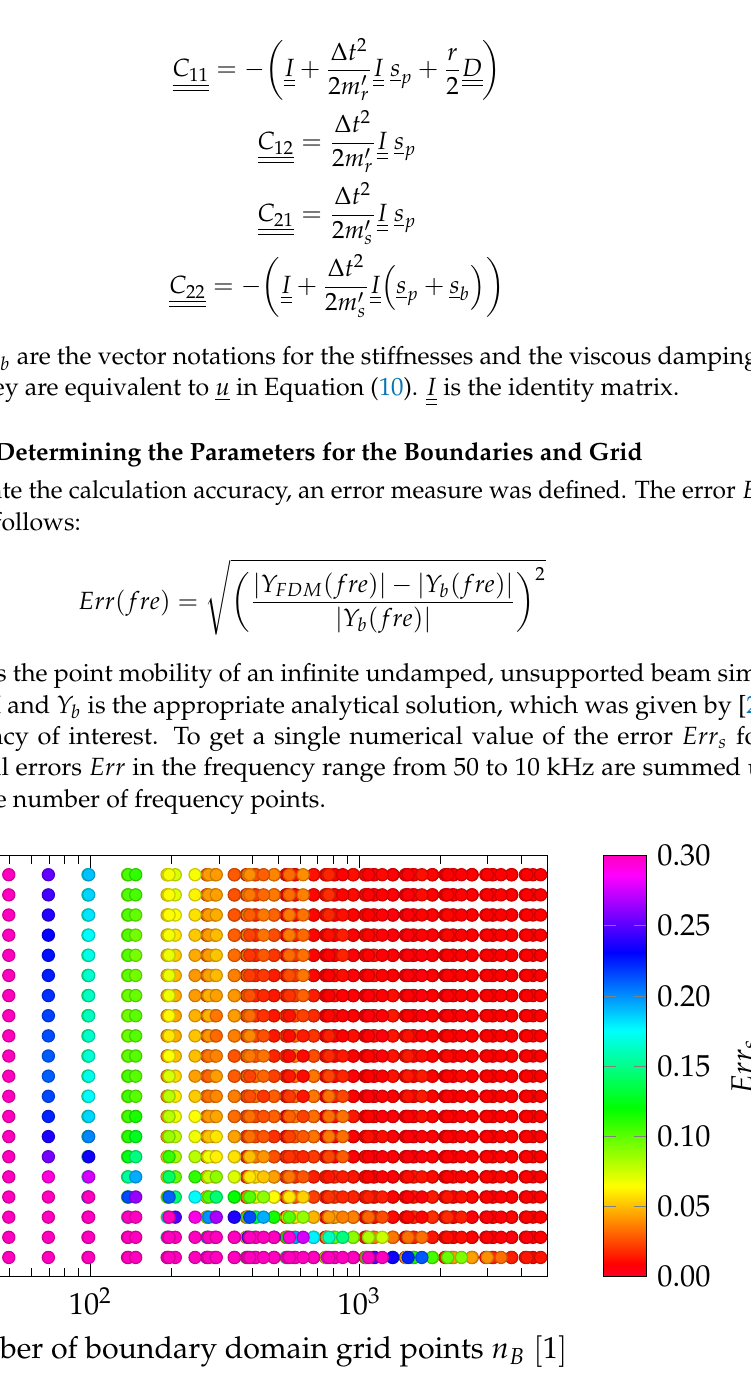
Figure A1. Error Err s of the simulation depending on the boundary-domain exponent α and the num- ber of boundary grid points n B . (The unspecified parameters are presented in Table